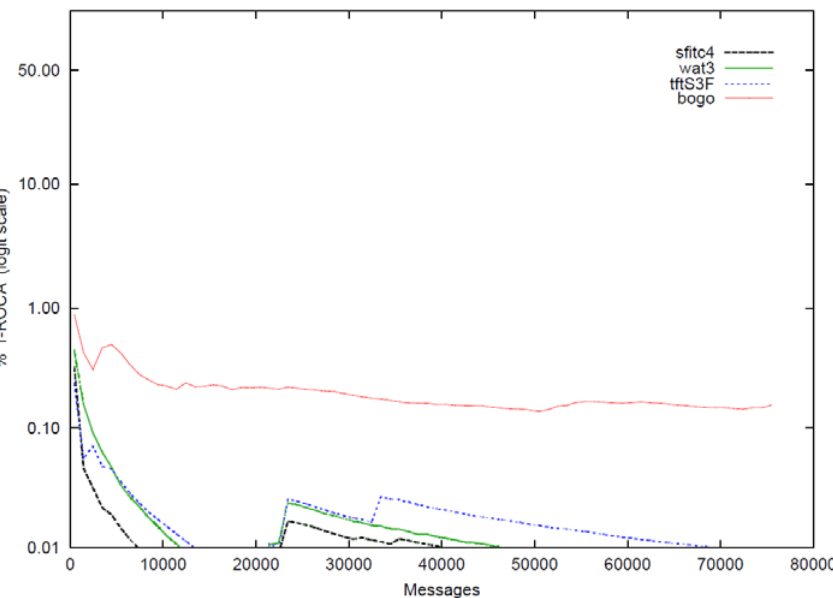
Fig. 6. ROC Learning Curves: Immediate Full Feedback on the Trec07p Corpus.